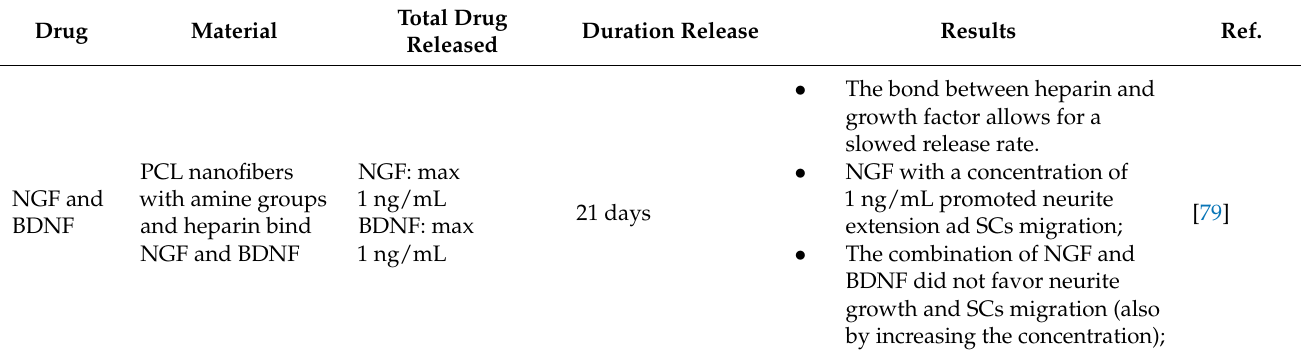
Table 4. Schematic list of e micro/nanofiber studies to enhance nerve regeneration.